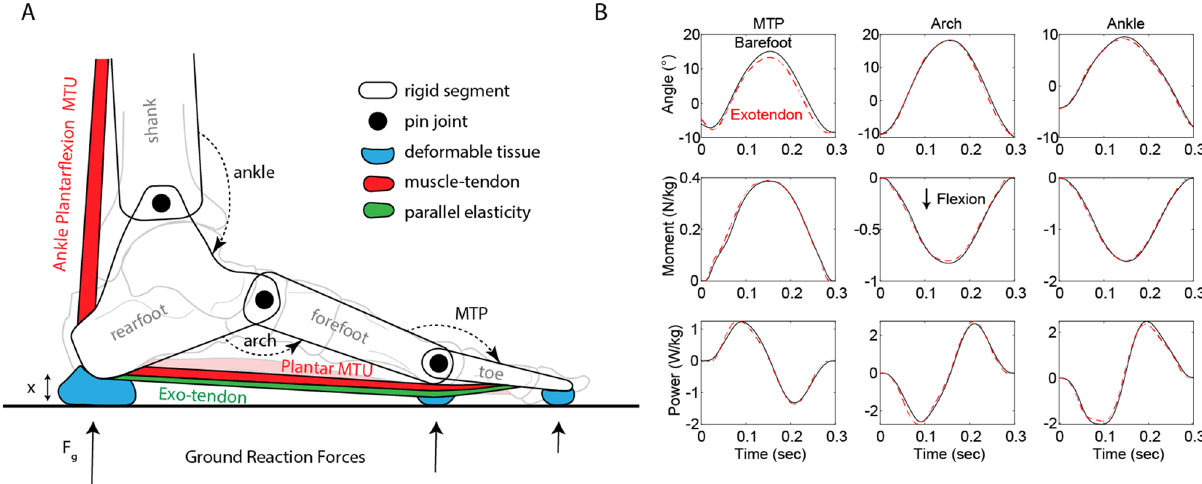
Figure 2. ( A ) A conceptual diagram of the inverse dynamics model used to take measurements of the foot and ankle during hopping. A series of four segments (shank, rearfoot, forefoot, and toe) are connected via 3 pin joints orientated perpendicular to the sagittal plane (ankle, arch, and MTP). The plantar MTU is a windlass mechanism acting across both the arch and MTP, through which both the passive elastic aponeurosis and intrinsic foot muscles generate force. During the experiment, an exotendon was also added and thereby included in measurements of the plantar MTU. Ground reaction forces as measured by a force plate are distributed across the three foot segments based on the relative positioning of each segment with respect to both the ground and the centre-of-pressure of the force plate ( B ) Angles, moments, and powers of the MTP, arch, and ankle for hopping at 2.33 Hz. Data are averaged across all participants, and the barefoot (black-line) is compared to wearing the exotendon (dashed red